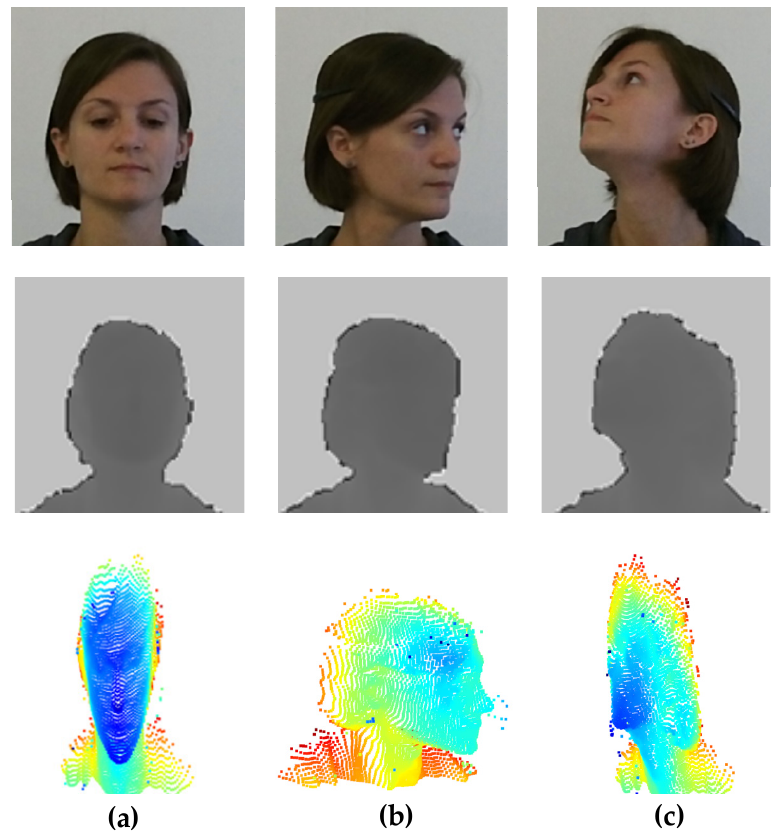
Figure 9. Example of Pandora split. Where ( a ) represents the A 1 sequence, with the least head pose interference; ( b ) represents the A 2 sequence with a little head pose interference; and ( c ) represents the A 3 sequence. Tree pose angles are greater than 10 ◦ .